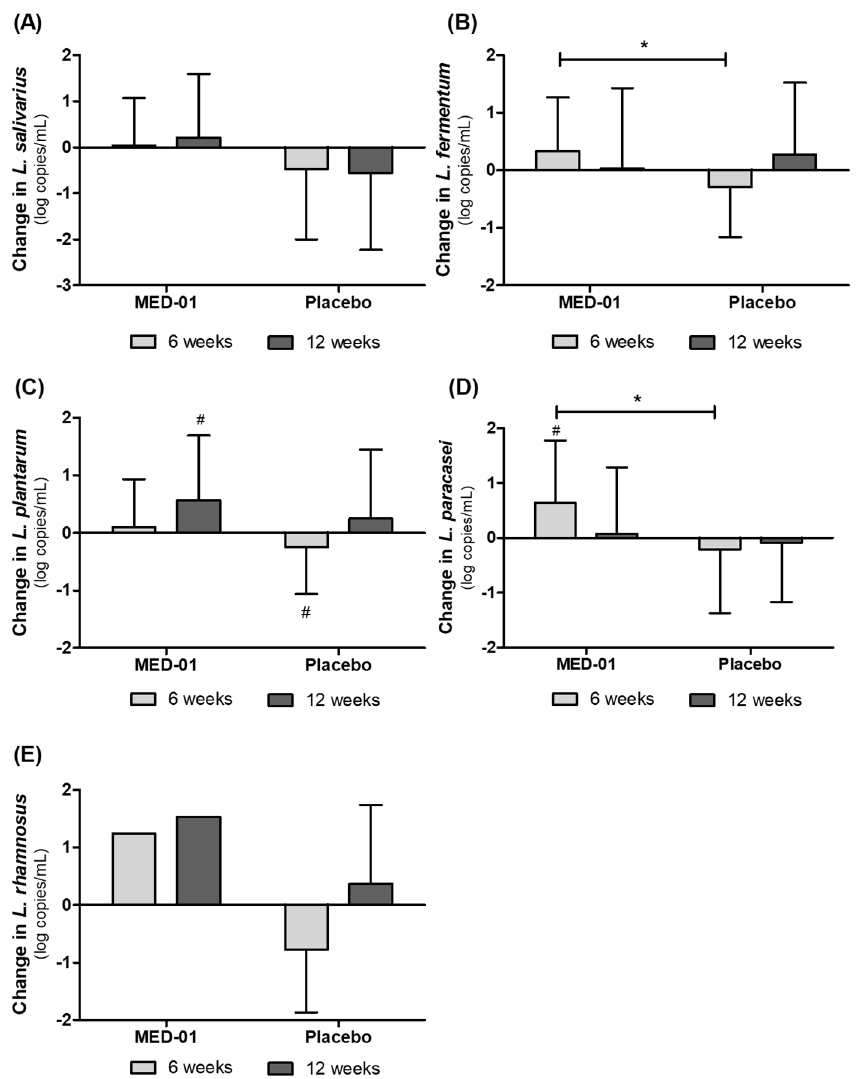
Figure 4. Effect of MED-01on vaginal lactic acid bacteria (LAB), as determined by quantitative PCR from baseline to 12 weeks after randomization of subjects. ( A ) Ligilactobacillus salivarius , ( B ) Limosilactobacillus fermentum , ( C ) Lactiplantibacillus plantarum , ( D ) Lacticaseibacillus paracasei , and ( E ) Lacticaseibacillus rhamnosus . Values are presented as the mean of change in log copies/mL ± SD. * p < 0.05 derived from a two-sample t -test between two groups, MED-01 vs. placebo; # p < 0.05 derived from a paired t -test within groups, Weeks 0 vs. 12.